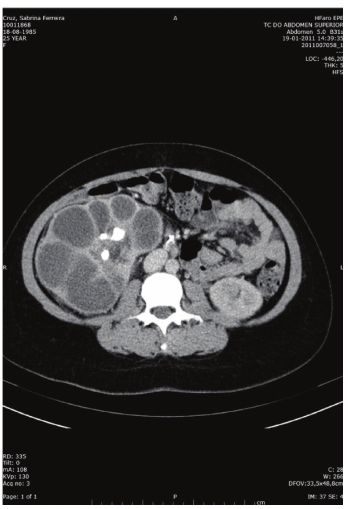
Figure 2: Abdominal pelvic CT: presence of a dilated collecting system with the presence of a coraliform calculus of 55 mm in the renal